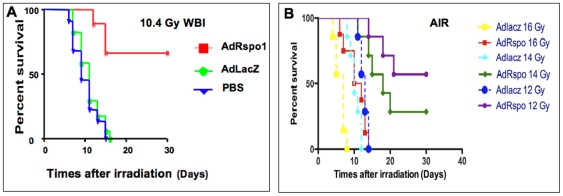
AdRspo1 treatment protected C57Bl/6 mice from radiation-induced mortality.Kaplan-Meier survival of C57Bl/6 mice treated with AdRspo1 or AdLacZ prior to WBI (10.4Gy) (Fig 2A) and 12–16 Gy AIR (Fig 2B) . Note a significant (p<0.003) increase in median survival in AdRspo1-treated mice with a median survival time of 27±1.6 days, compared to AdLacZ cohorts, 10±1.4 days. With 12–14Gy AIR median survival time for AdLacZ treated animals is 13±1.2 and 11±1.6 days compared to 25±1.3 and 19±1.4 in AdRspo1-treated animals.